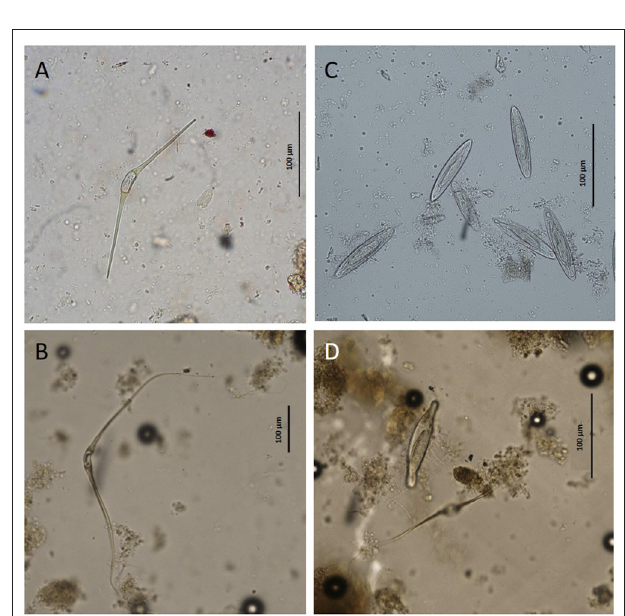
FIGURE 2 | Eggs of Ogmogaster antarcticus (A,B) and Bolbosoma sp. (C,D) from Balaenoptera physalus obtained by sedimentation and flotation method (A,C) and Mini-FLOTAC technique (B,D)